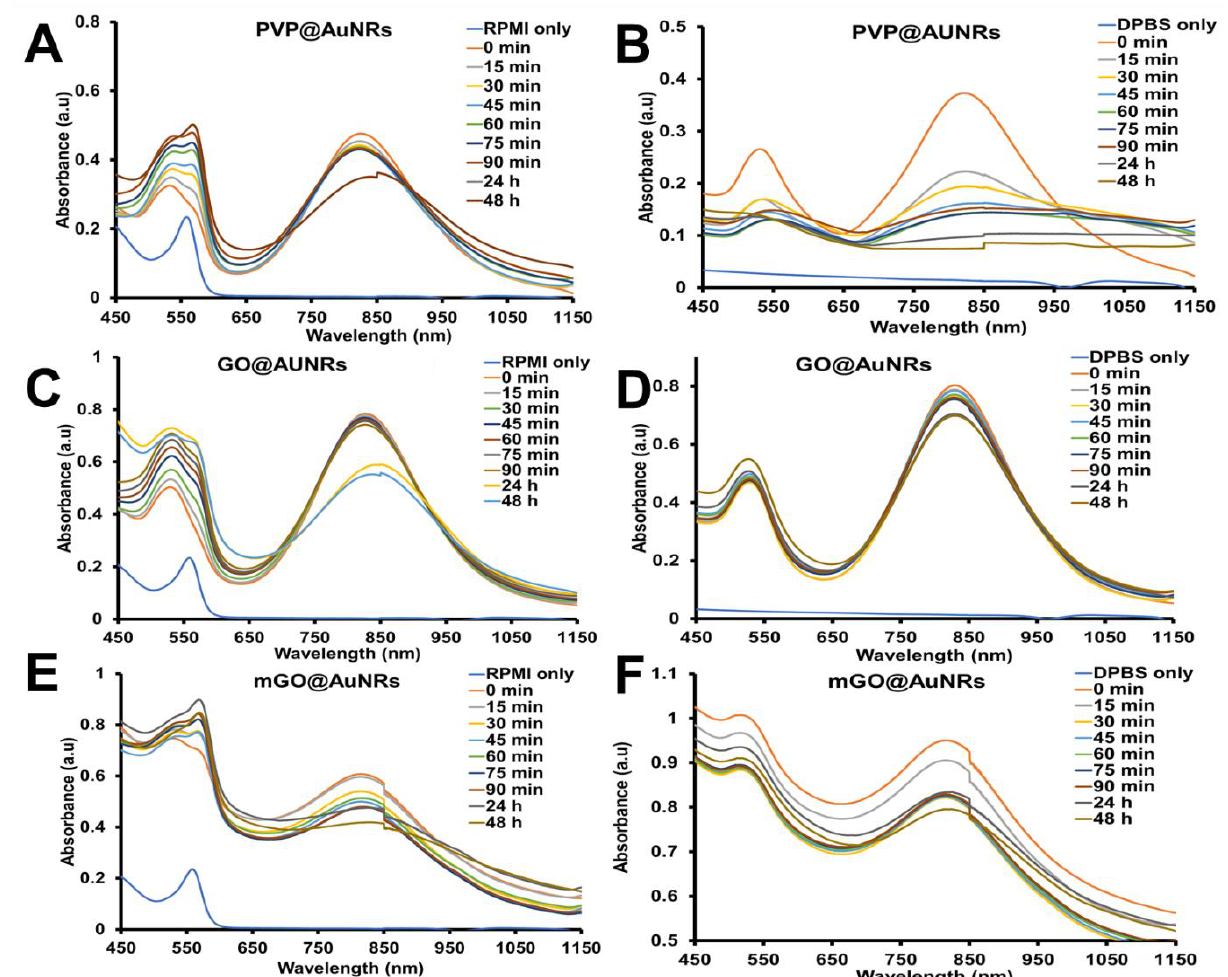
Figure 4. UV-Vis-NIR spectrum of ( A , B ) PVP @AuNRs, ( C , D ) GO@AuNRs, and ( E , F ) mGO@AuNRs, in RPMI and PBS, respectively, at different time intervals.